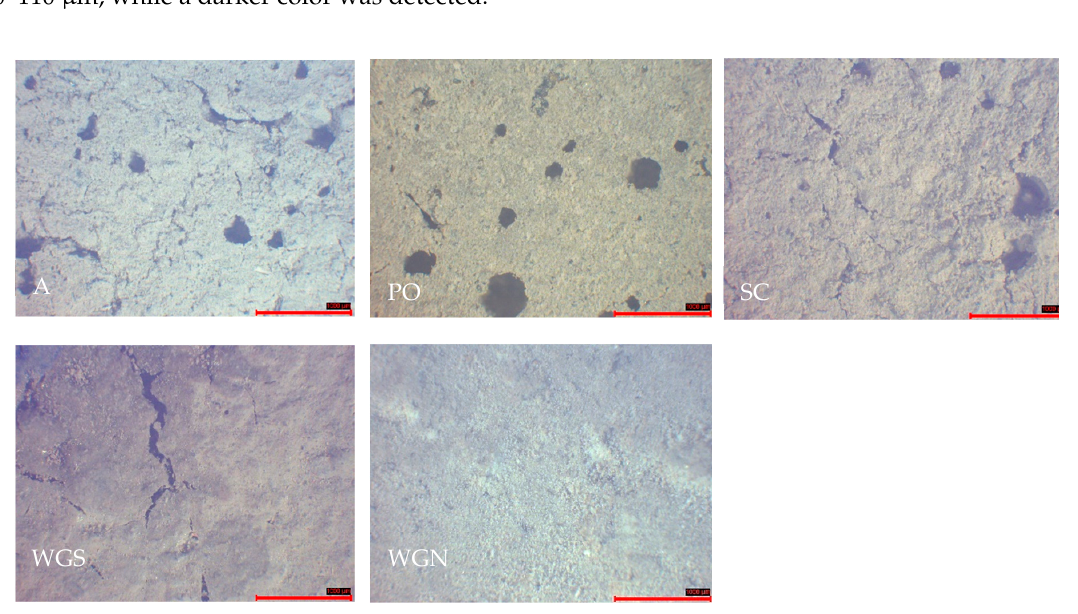
Figure 6. Stereoscopic observation of the mortars at the age of one year (scale 1000 μ m).